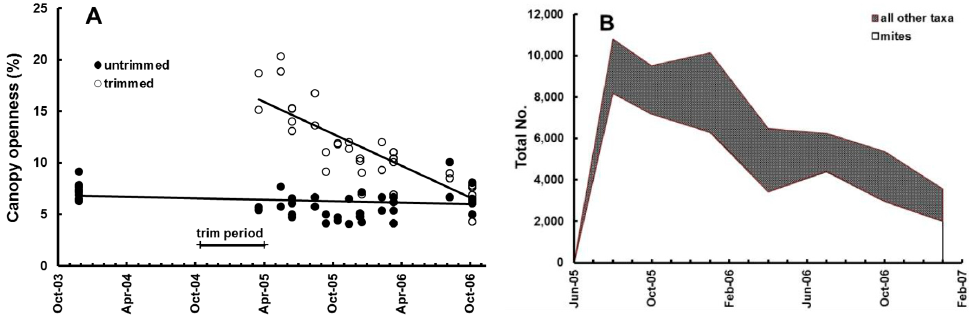
Figure 3. Changes over time. ( A ) Canopy openness; ( B ) No. of invertebrates in litter bags at each recovery. See [19].